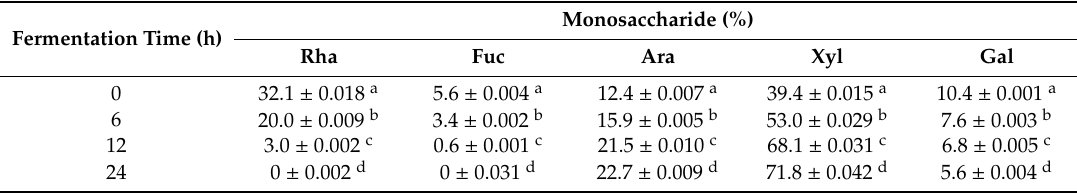
Table2. Compositionsandcontentsofresidualmonosaccharidesatdi ff erenttimepointsoffermentation. Fermentation Time